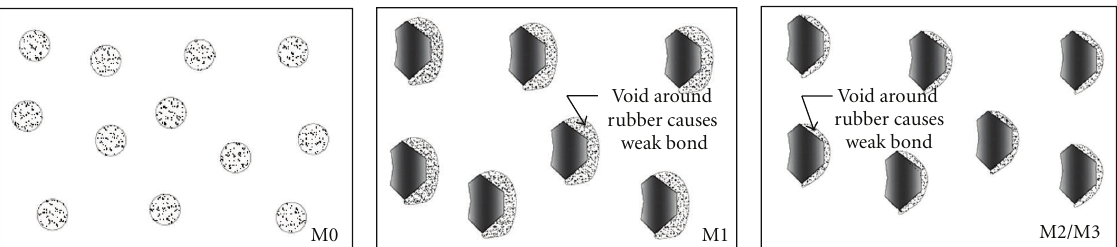
Figure 6: Comparison di ff erent shapes of voids in concrete.